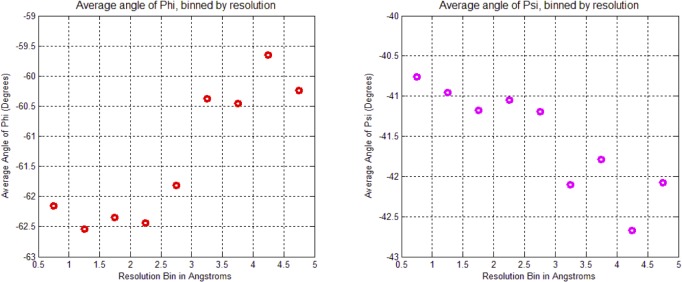
Average values of Φ (Phi) and Ψ (Psi) torsion angles of helical residues in PDB binned by nominal crystallographic resolution.This compensatory change in Φ, Ψ is due to a “crankshaft” motion [39] of the amide bond that maintains the relative positions of the α-carbons of the peptide backbone despite significant deviations in Φ, Ψ torsions.